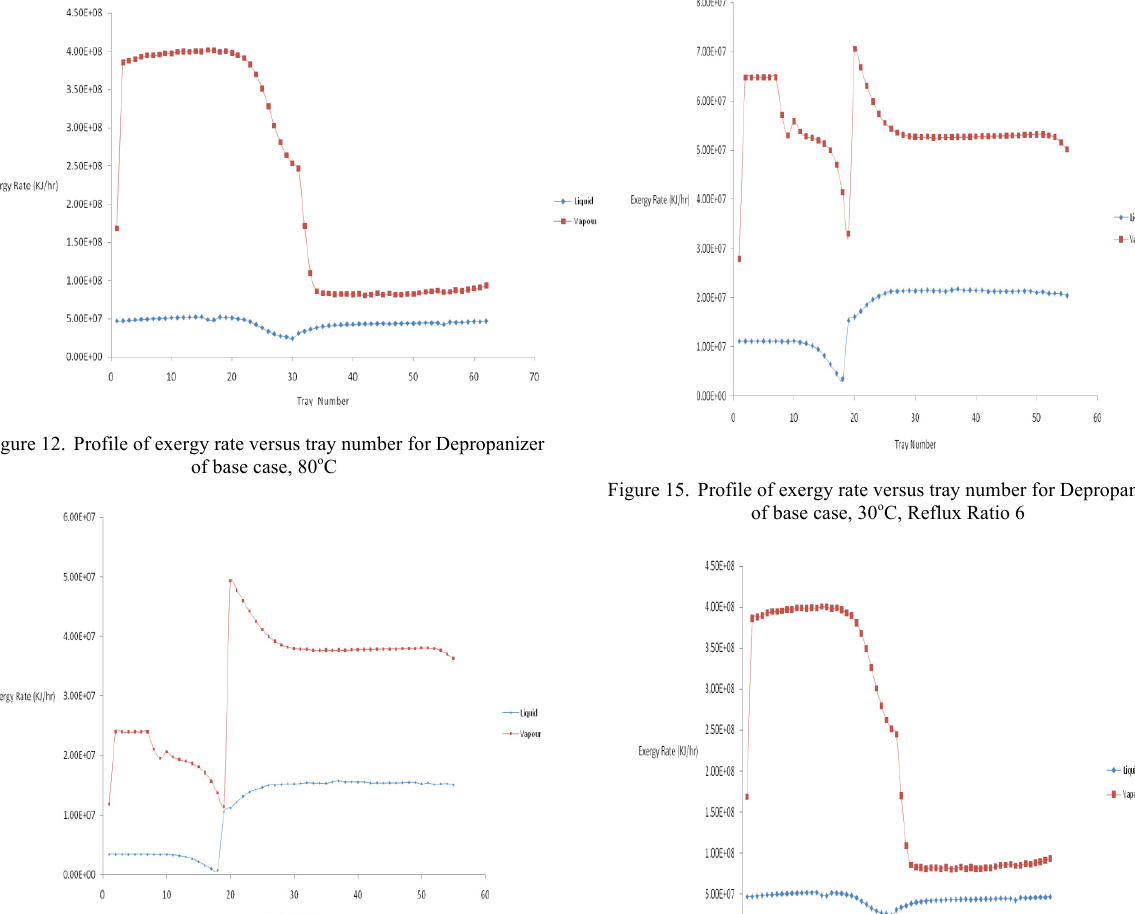
Figure 11. Profile of exergy rate versus tray number for Depropanizer of base case, 80oC